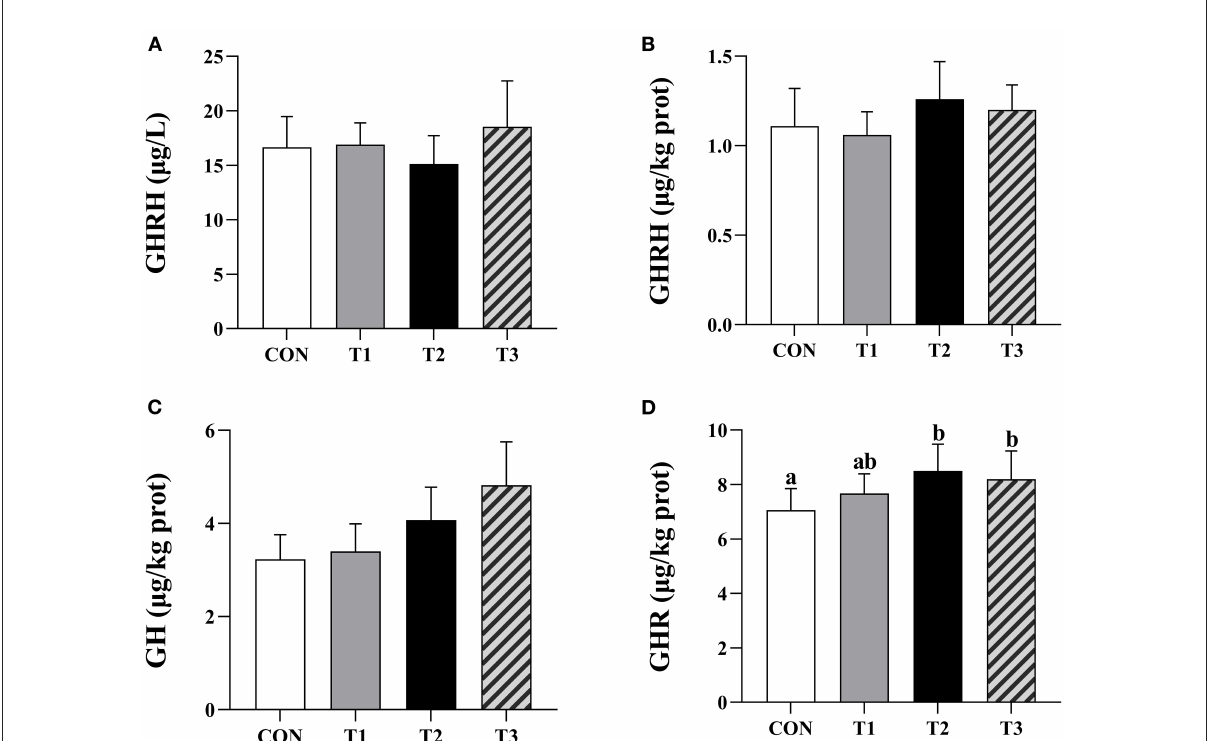
FIGURE2 Effects of ZEN on the contents of serum GHRH, hypothalamus GHRH, pituitary GH, and ovarian GHR. Above the bar no letter or the same letter mean no significant ( P > 0.05), while with different letter mean significant difference ( P < 0.05). In (A) , N = 8, in ( B–D) , N = 4, bars represent the means ± standard deviation (SD). Growth hormone-releasing hormone (GHRH), Growth hormone (GH), Growth hormone receptor (GHR). The content of ovarian GHR in each group: 7.06 ± 0.79 a , 7.67 ± 0.72 ab , 8.50 ± 0.98 b , 8.20 ± 1.03 b , respectively, P = 0.03. In the same row, values with different small letter superscripts mean significant difference ( P <